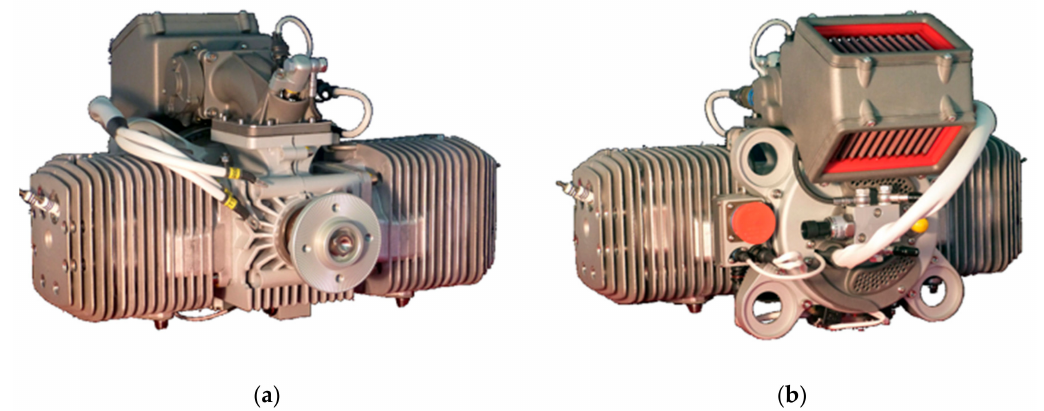
Figure 2. Overall look of the initial prototype engine ( a ) Front view and ( b ) Back